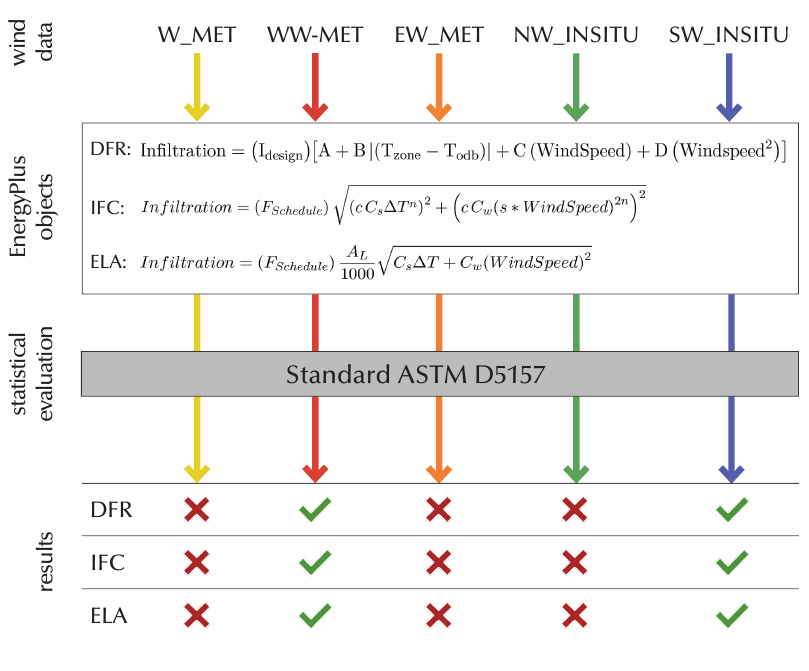
Figure 12. Summary of the paper